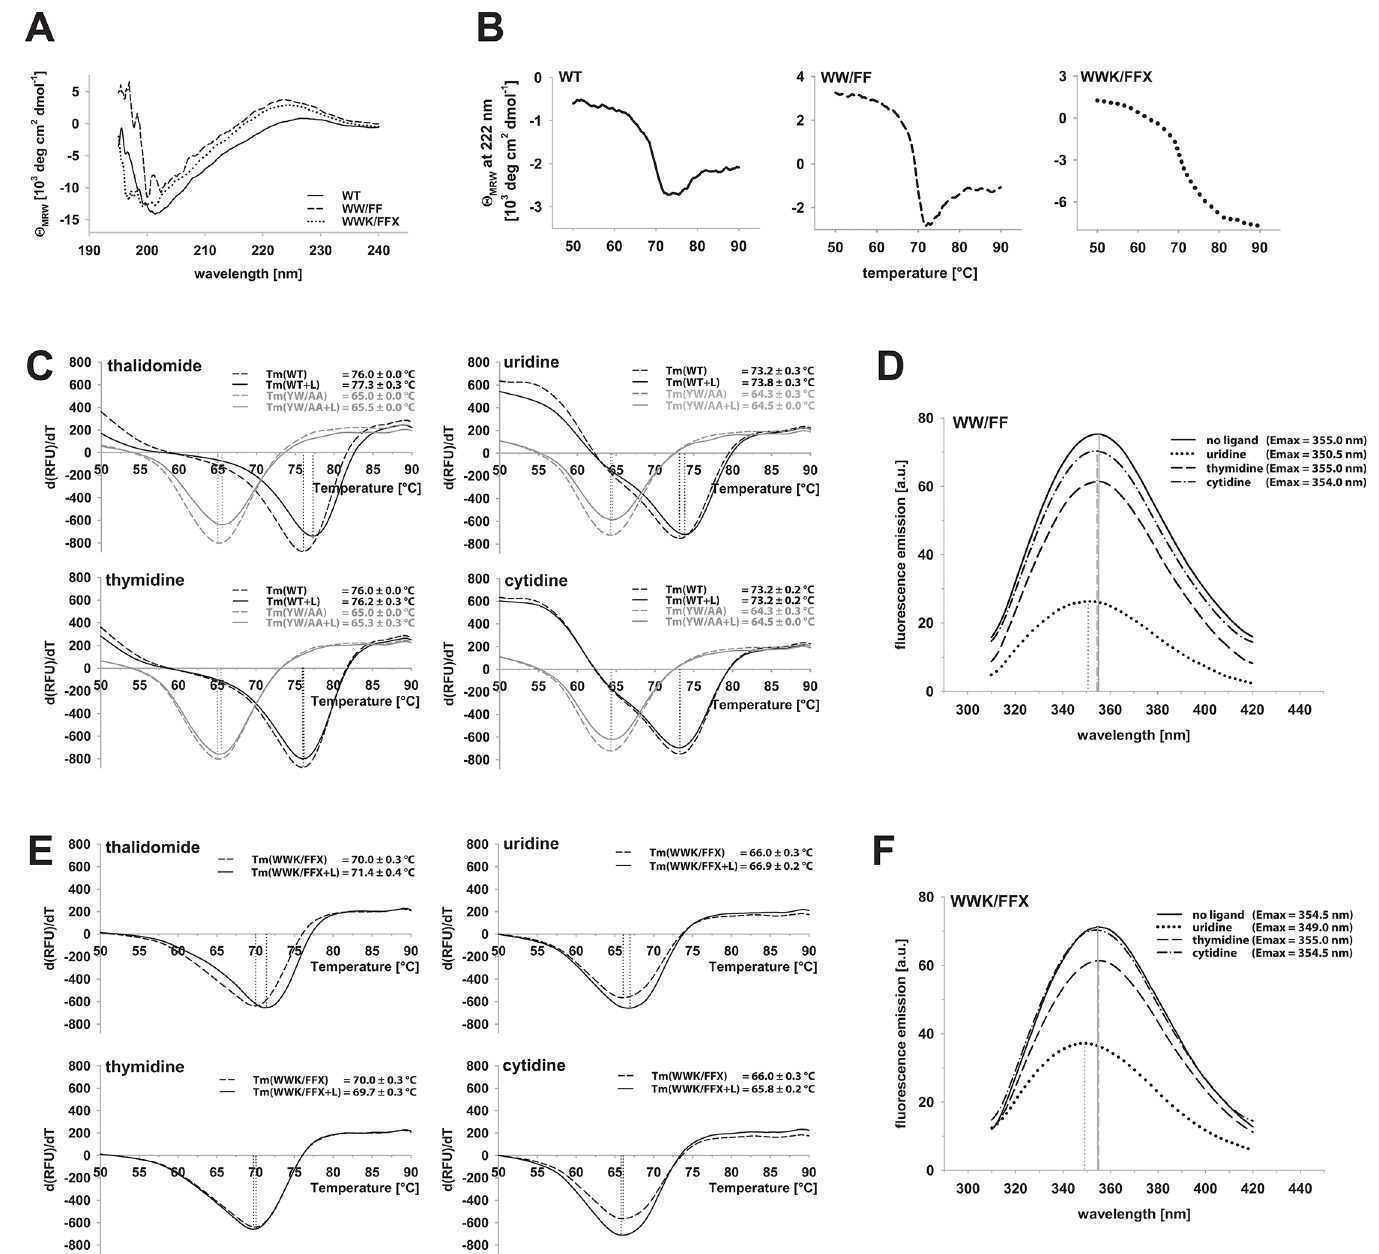
Fig 5. Biophysical characterization of MsCI4 and mutants. (A) Far-UV CD spectra of wild-type (WT) MsCI4 and mutants MsCI4 WW/FF and MsCI4 WWK/FFX , and (B) corresponding melting curves, monitored at 222 nm. (C) Thermal stability of MsCI4 and binding deficient MsCI4 YW/AA in presence of thalidomide, uridine, thymidine and cytidine, as determined in the thermal shift assay. Only thalidomide and uridine lead to a shift in melting temperature with (two-tail) p- values of 1.5e-3 and 4.9e-2 as determined in a two sample equal variance t-test. (D) Tryptophan fluorescence spectra of MsCI4 WW/FF in presence of uridine, thymidine and cytidine. The emission maximum is shifted to shorter wavelength only in presence of the binder uridine, which can be indicative for the folding of the binding site. Note also the pronounced quenching effect indicative for binding. (E) same as (C) for the MsCI4 WWK/FFX mutant. As for the WT, thalidomide and uridine lead to a thermal shift, with p-values of 4.0e-4 and 1.2e-3. (F) same as (D) for the MsCI4 WWK/FFX mutant. The presence of uridine has the same effect as on the